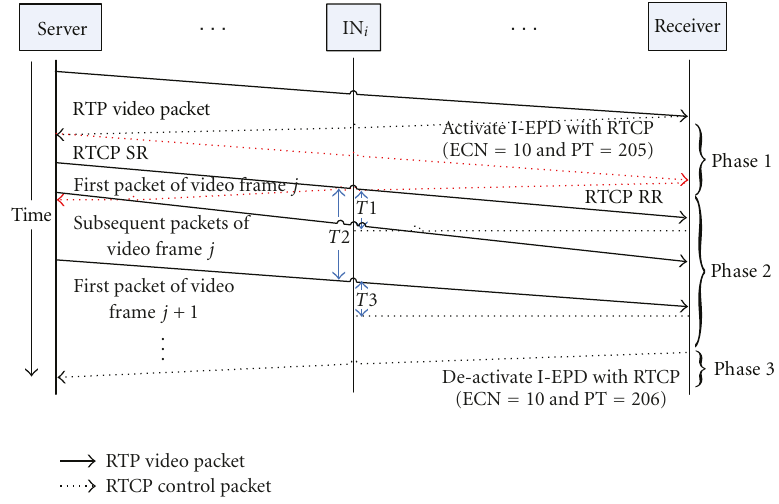
Figure 3: The proposed I-EPD with three